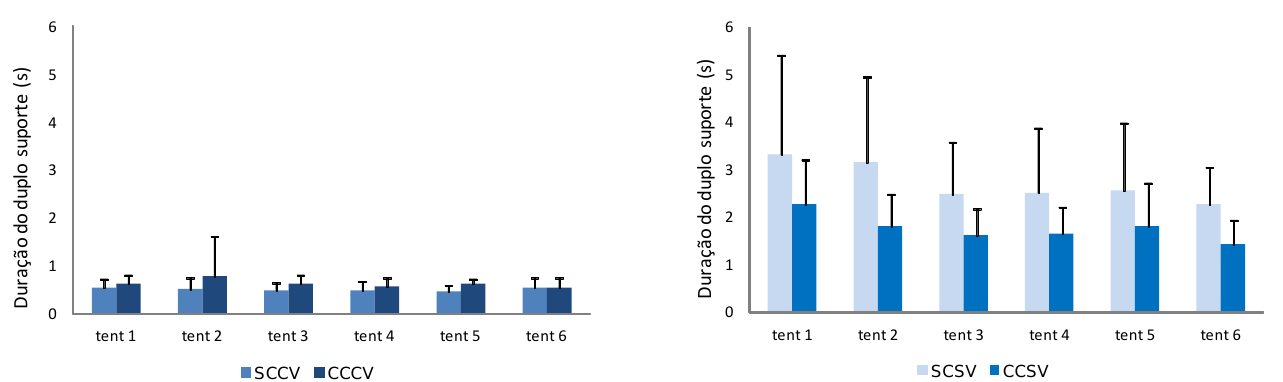
Figura 3. Média e desvio-padrão da duração da fase de duplo suporte nas condições experimentais com e sem o cão, mas com uso da visão (lado esquerdo) e com e sem o cão, mas sem o uso da visão (lado direito).